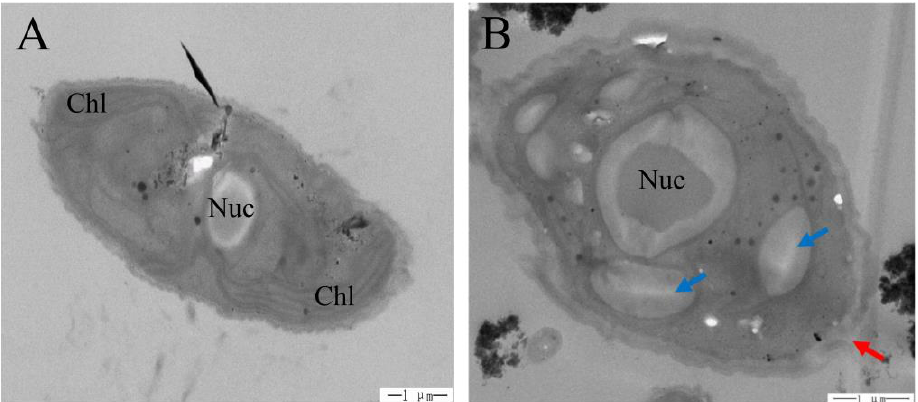
Figure 5. Effects of 10 nm TiO 2 on the cell structure of S. obliquus after 72 h exposure. ( A ) Control, and ( B ) 10 nm-TiO 2 . Blue arrow shows a vacuole while red arrow shows cell membrane breaking. Chl: Chloroplast; Nuc: Nucleus.